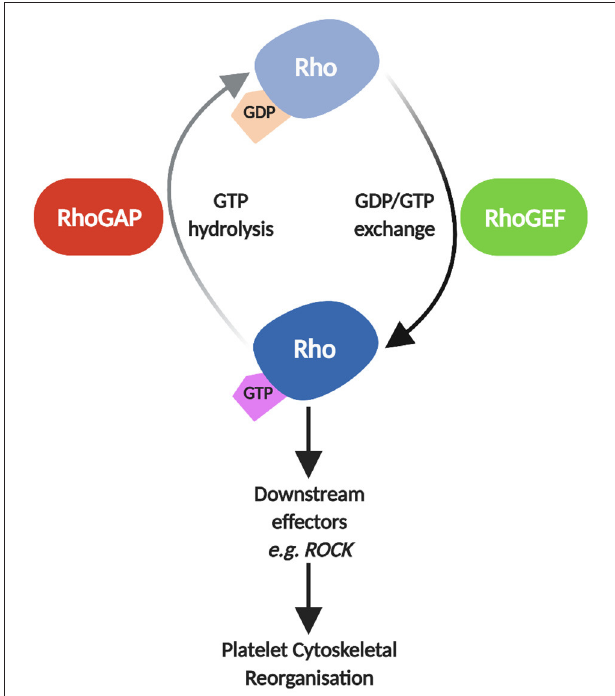
FIGURE 1 | Schematic of Rho GTPase regulation by RhoGAPs and RhoGEFs. In their inactive state, Rho GTPases such as RhoA, Rac1 and Cdc42 are GDP-bound. GEFs facilitate the dissociation of GDP and binding of GTP, activating Rho GTPases allowing them to interact with downstream effectors such as Rho Kinase (ROCK), Filamin-A, and Wiskott-Aldrich syndrome protein (WASp) leading to reorganisation of the platelet cytoskeleton (2, 3). GAPs subsequently catalyse the hydrolysis of GTP to GDP, reverting the Rho GTPase to its inactive state, inhibiting Rho GTPase signalling. Image created using